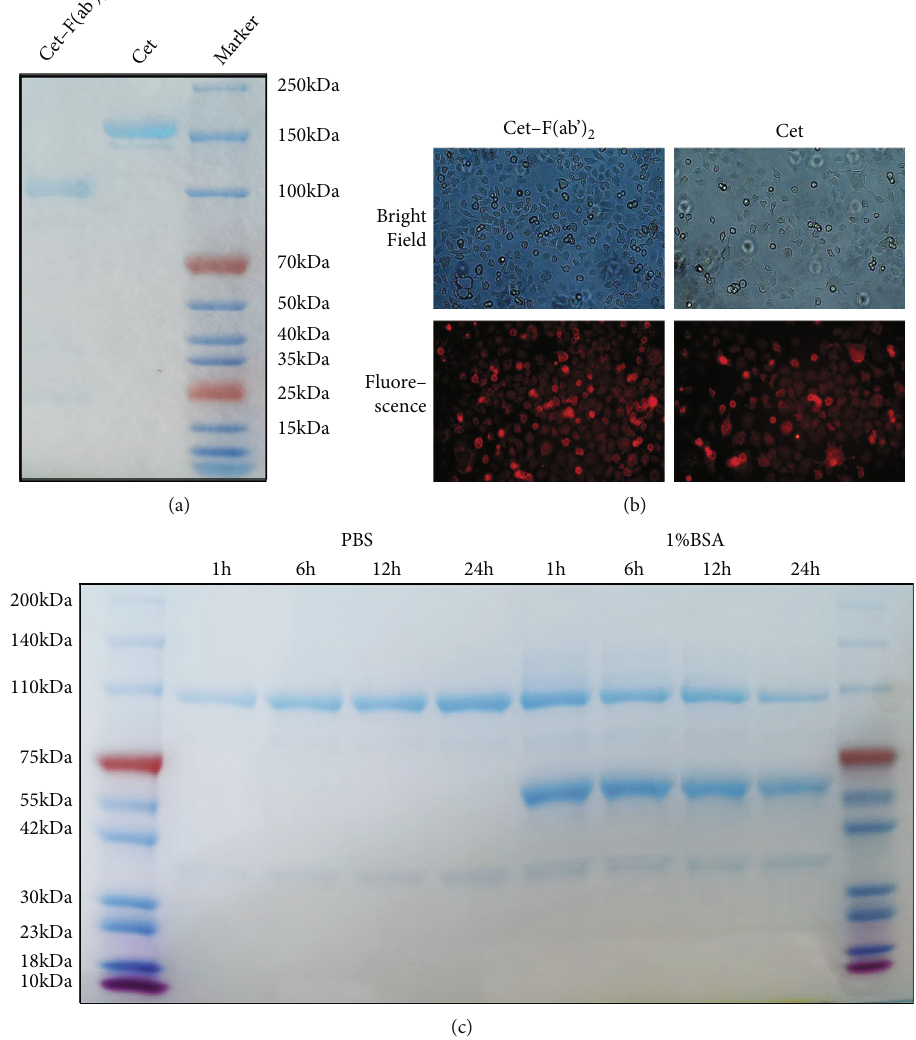
Figure 3: Veri fi cation of Cet-F(ab ′ ) on its molecular weight, binding a ffi nity to EGFR positive cells, and in vitro stability. (a) SDS-PAGE 2 showing that the molecular weight of Cet-F(ab ′ ) and cetuximab is 100 kDa and 150 kDa, respectively. (b) Immunocytochemistry showing 2 and cetuximab to MGC803 cells. (c) SDS-PAGE illustrating the excellent stability of Cet-F(ab ′ ) high binding ability of Cet-F(ab ′ ) 2 incubation in PBS and 1% BSA over 24